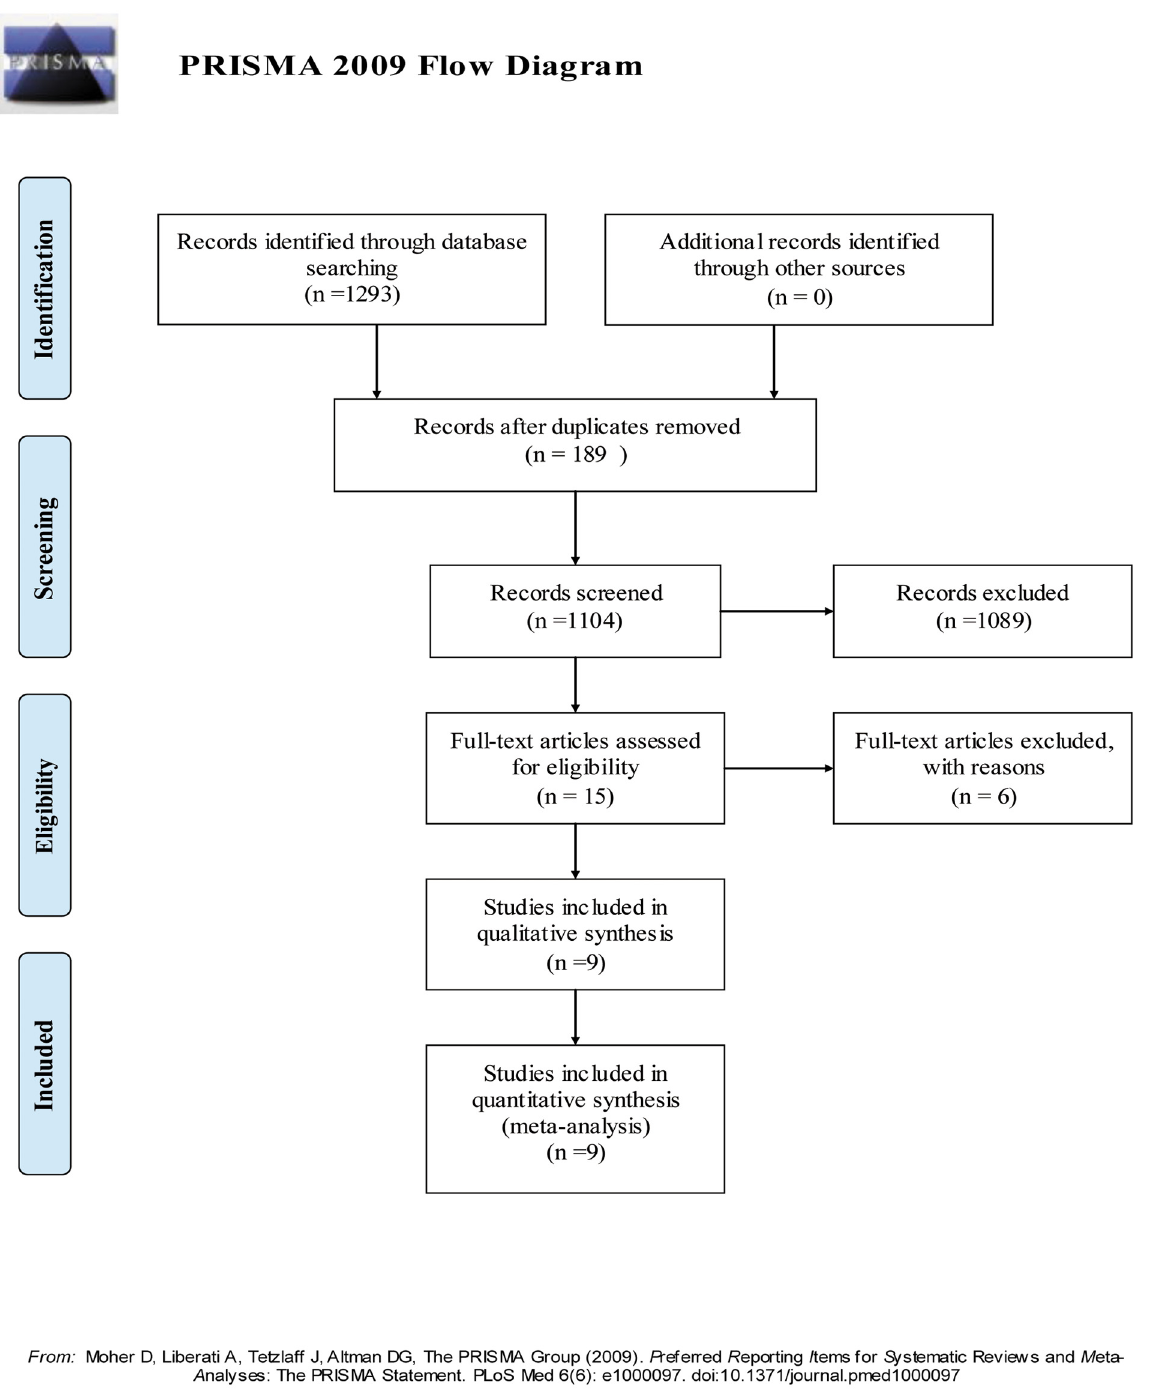
Fig 1. Flow chart summarizing the selection process of studies.